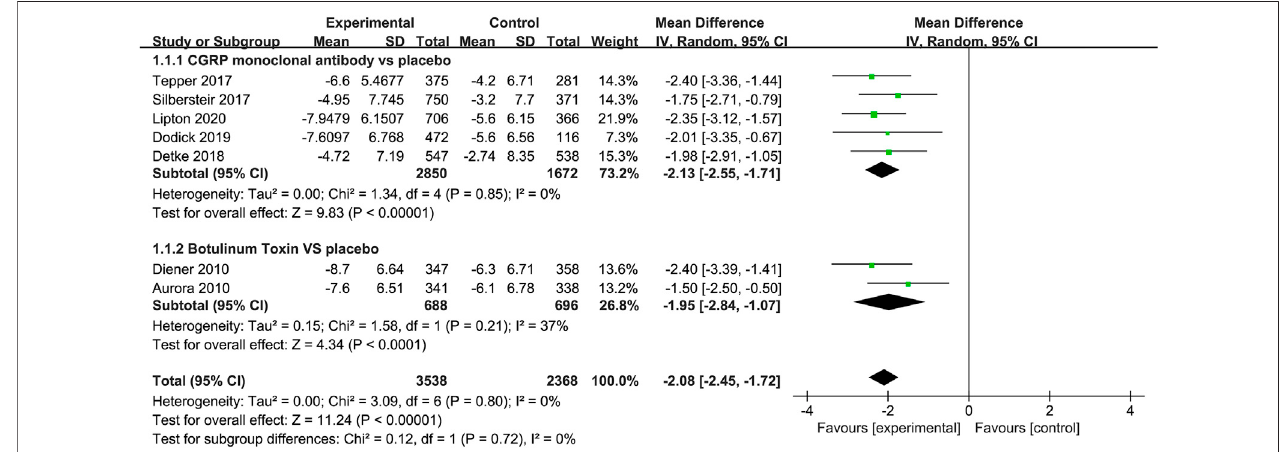
FIGURE3| Pooledweightedmeandifferencesofchangeinmigrainedaysinthetreatmentgroupcomparedwithplacebo;diamondindicatestheestimatedrelative risk with 95% con fi dence interval for the pooled patients.